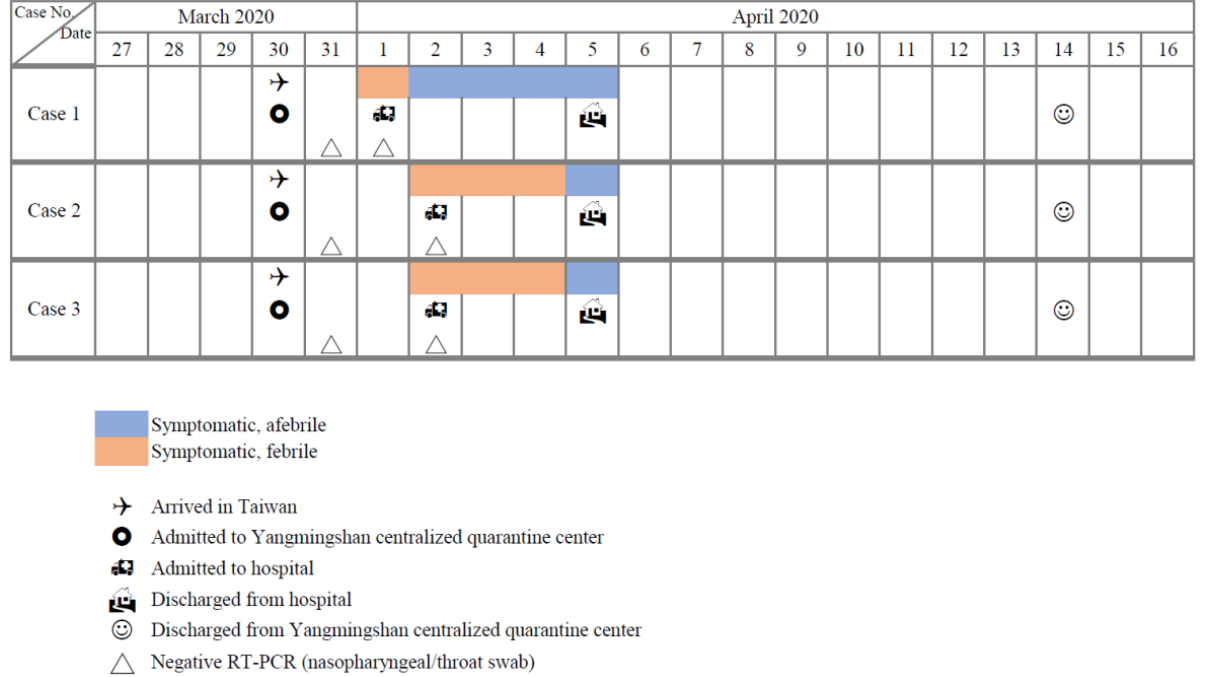
Figure 2. Time course of clinical symptoms in the three hospitalized travelers.